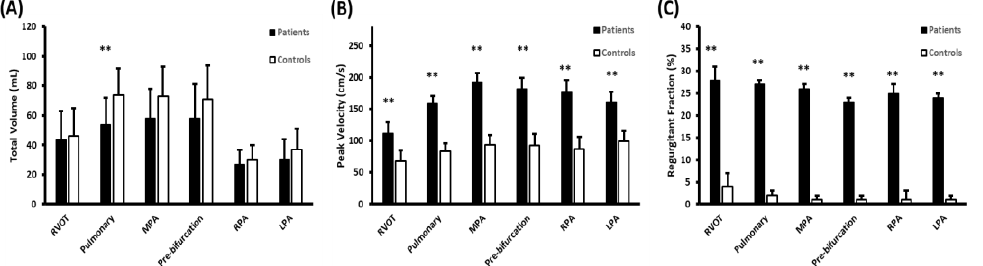
Figure 5. Plane hemodynamic assessment along the pulmonary artery using 4D flow. Right ventric- ular outflow tract (RVOT), pulmonary valve, main pulmonary artery (MPA), pre-bifurcation, right pulmonary artery (RPA), and left pulmonary artery (LPA). Panel ( A ) shows the assessment of total flow. Panel ( B ) shows the peak velocity assessment. Panel ( C ) shows the assessment of regurgitant fraction. ** indicates p - value ≤ 0.001 between rTOF patients and controls.